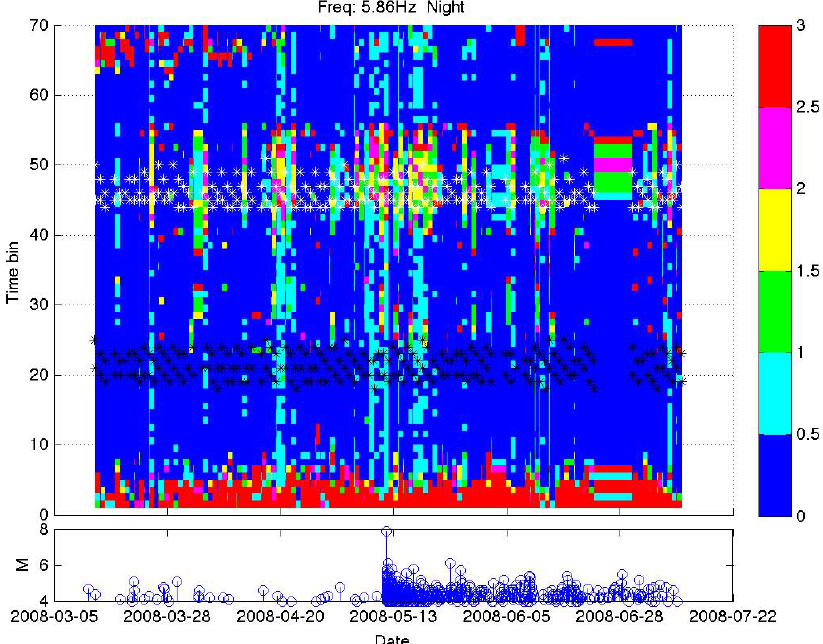
Fig. 2. The upper panel shows the ratio of the variation of the measured ULF wave power averaged into 30s bins to the mean power measured along a particular orbital track ( y axis). The x axis shows the date. The white crosses mark the points in the DEMETER orbit when it passed closest to the epicentre whilst the black indicate the closets passes of DEMETER to the southern conjugate point. The lower panel shows the occurrence time of earthquakes with magnitude M > 4 that occurred within 1500km of the Sichuan